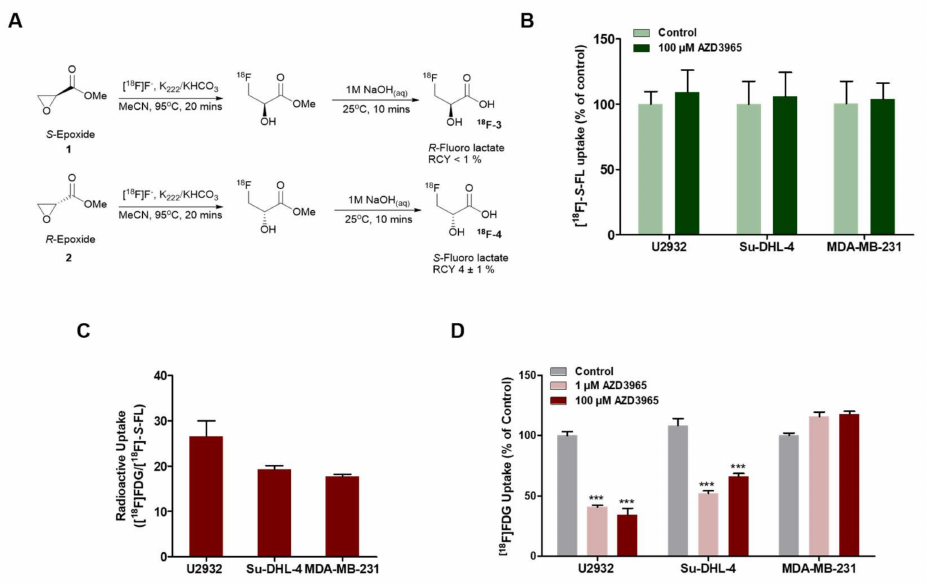
Figure 2. DLBCL cells predominantly utilize glucose in vitro. ( A ) Synthetic schemes for [ 18 F]- R -fluorolactate and [ 18 F]- S -fluorolactate ([ 18 F]- S -FL). ( B ) Uptake of [ 18 F]- S -FL (1h) in U2932, Su-DHL-4 and MDA-MB-231 cell lines in response to AZD3965 treatment (100 µ M, 4h) ( C ) Comparative radioactive uptake of [ 18 F]- S -FL and [ 18 F]FDG (1h) expressed as the ratio of [ 18 F]FDG relative to mean [ 18 F]- S -FL. ( D ) Uptake of [ 18 F]FDG (1h) following treatment with 1 or 100 mM of AZD3965 (4 h). All data are average ± SEM, expressed as percentage of control or as percentage of injected dose, normalized to protein content (%ID / mg) ( n = 6–12). *** p ≤